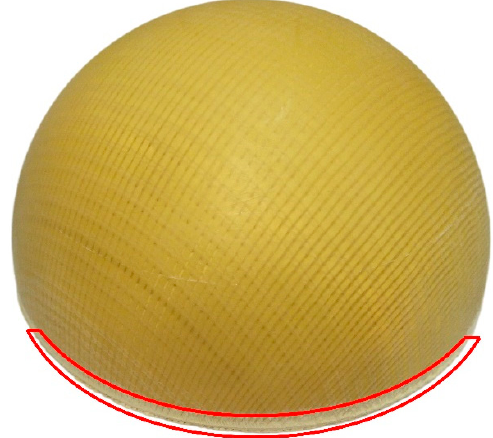
Figure 9. Local defects caused by mechanical cutting.